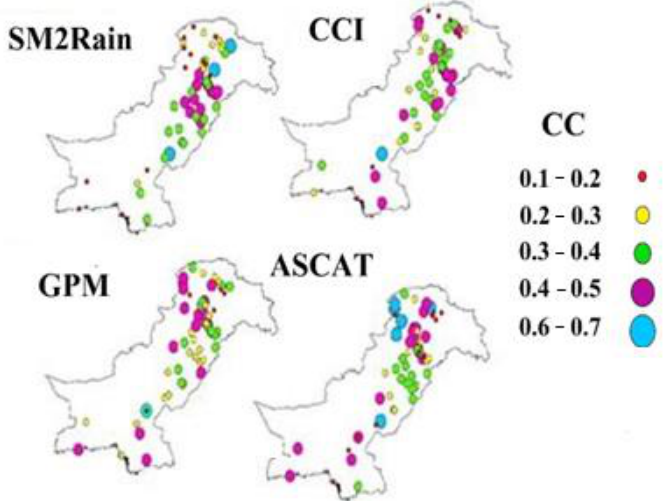
Figure 7. CC’s spatial distribution of all SPPs .